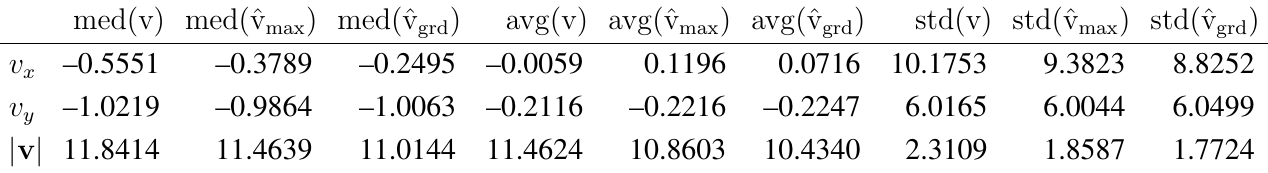
Table 1. Summary statistics for STM processing averaged over all 45 orbiting cloud images.